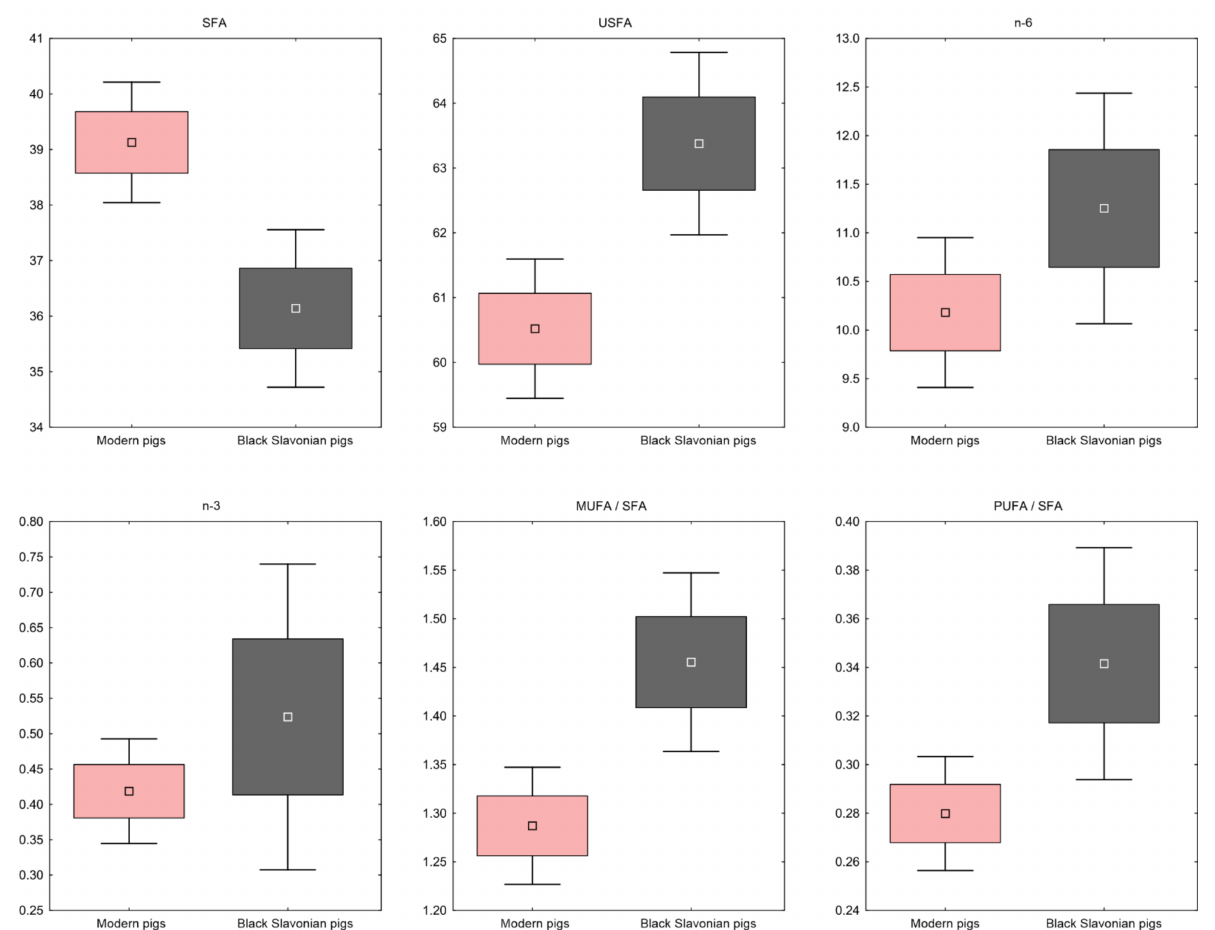
Figure 1. Box plots showing the differences in main fatty acids; SFA, USFA, n -6, n -3 and ratios MUFA/SFA and PUFA/SFA between the BP and MP groups. The differences between groups were statistically significant for SFA, USFA, MUFA/SFA and PUFA/SFA as p < 0.05. Inner points within boxes represent mean, boxes represent mean ± SE, and whiskers represent mean ±